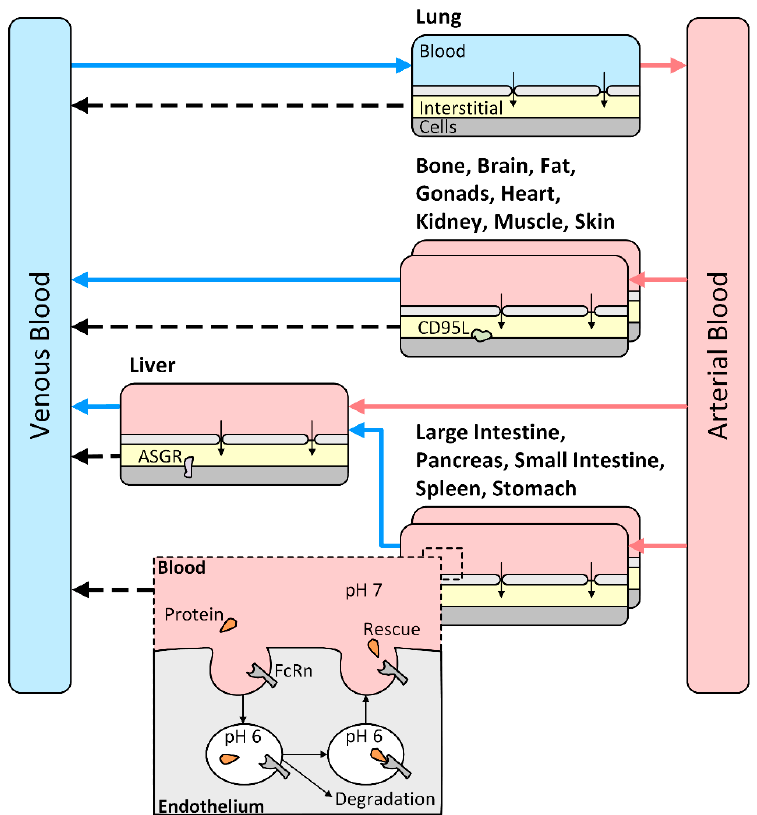
Figure 1. Model structure of the physiologically-based pharmacokinetic model, extended based on [16]. Each of the 15 organ compartments consist of a vascular space (pink or blue), containing blood serum and blood cells, an endothelial barrier (light grey, interrupted by small and large pores), containing lysosomal degradation and rescue thereof by the neonatal Fc-receptor (FcRn), an interstitial space (yellow), connected to the venous blood compartment by organ-specific lymph flows, and a cellular space (dark grey), which is not accessible to large molecules without receptor-mediated uptake. The target of asunercept, CD95L, is mainly expressed on the surface of immune cells, with low levels on neurons, reproductive cells, and other tissues. The asialoglycoprotein receptor (ASGR) is expressed on the surface of hepatocytes and removes glycoproteins with exposed galactose residues from the circulation, which are characterized by the lack of terminal sialic